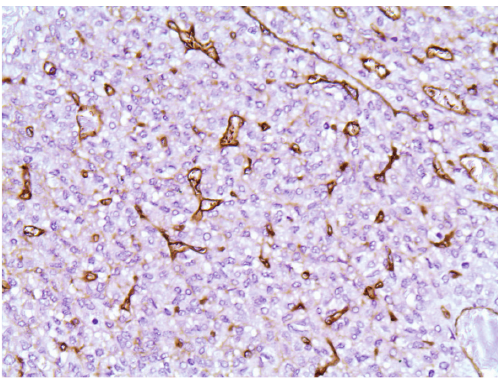
Figure 6: CD34 stain,